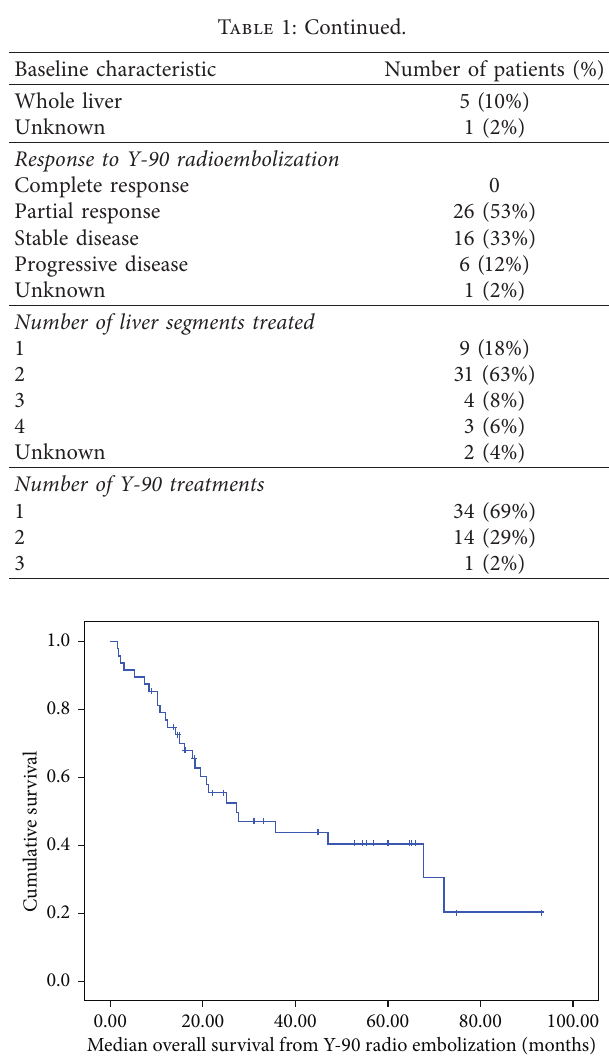
Figure 1: Kaplan–Meier curve of overall survival from initiation of Y-90 radioembolization.